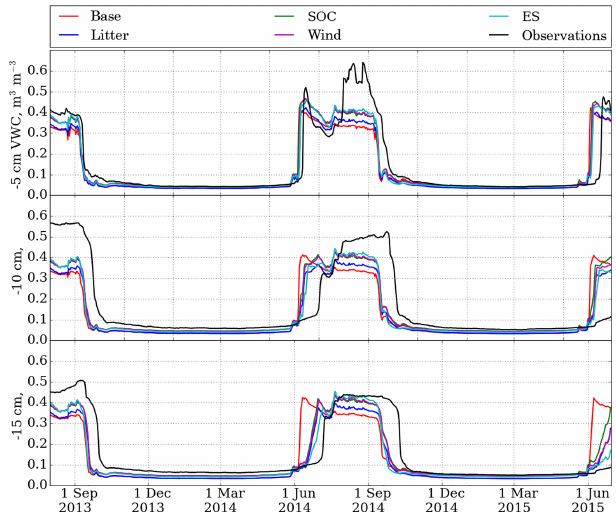
Figure 11. Observed and simulated daily mean soil volumetric wa- ter content (VWC) at depths of 5, 10 and